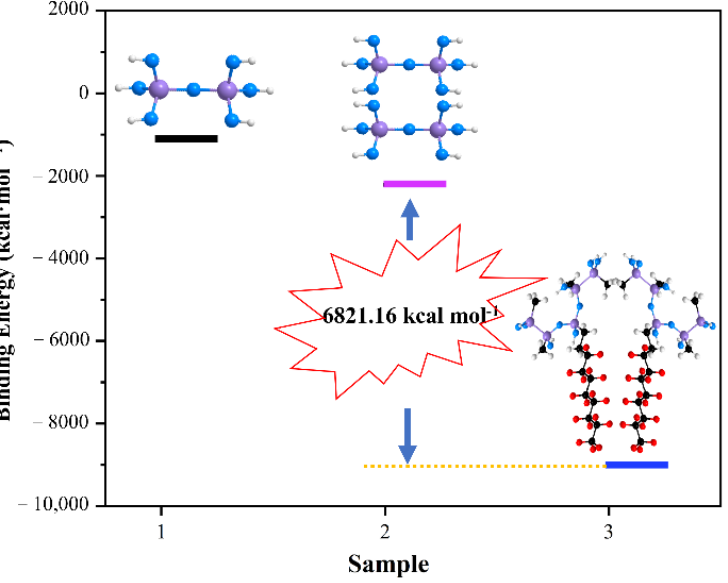
Figure 6. Diagram of binding energy (1-SiO 2 , 2-two SiO 2 molecules, 3-two FAS-17-modified